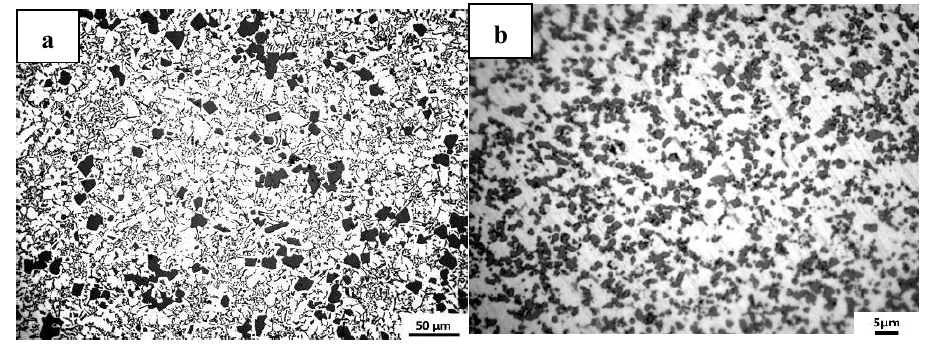
Figure 1. Microstructure of FSM master alloy: ( a ) prepared by water-cooler copper mold. ( b ) prepared by melt spinning